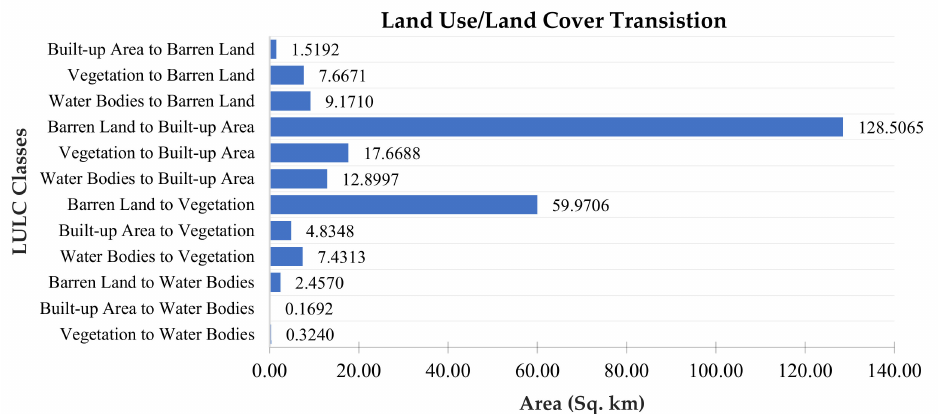
Figure 7. Land Use/Land Cover Transitions in Kano Metropolis, Nigeria